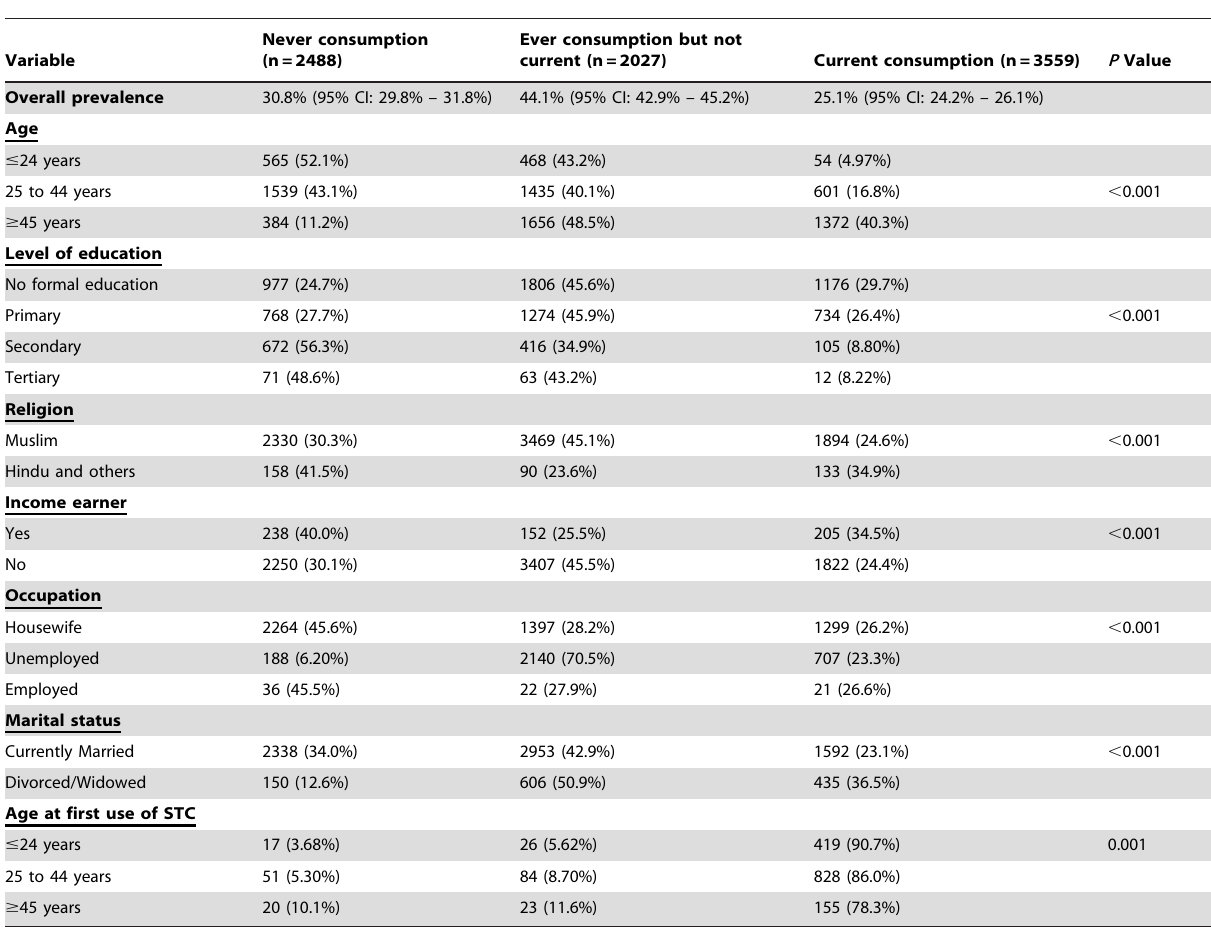
Table 1. Smokeless tobacco consumption by demographic factors (n